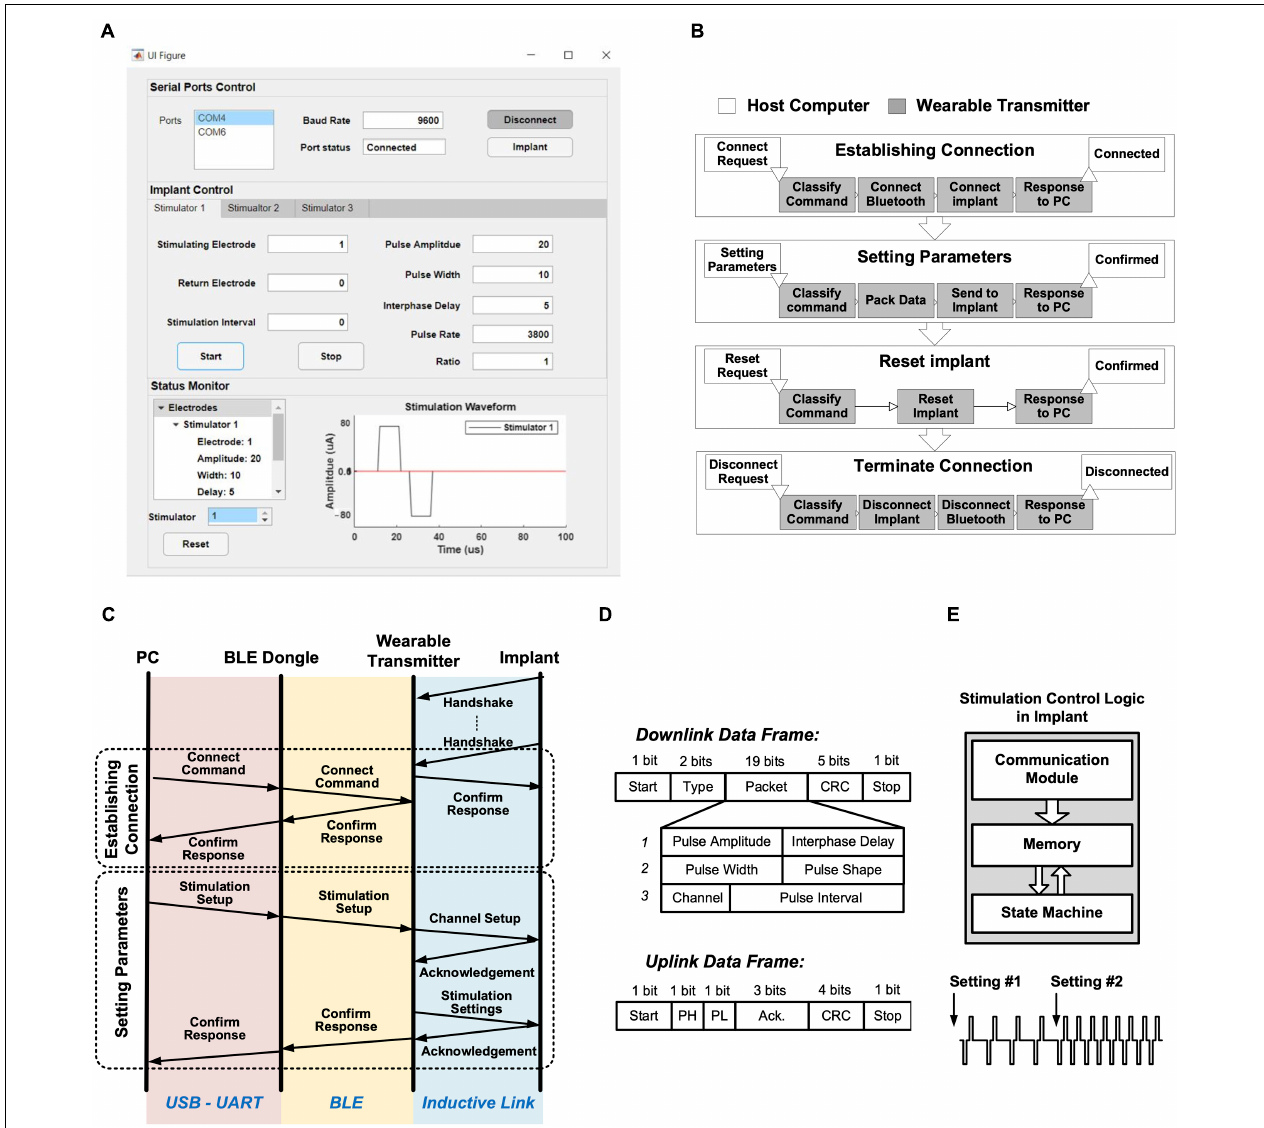
FIGURE 5 | Stimulation control protocol: (A) Graphical user interface; (B) Four procedures for operating the implant from a host computer, with flowcharts on the wearable transmitter in each procedure; (C) Overall communication procedure between the host computer and the implant for establishing connection and setting stimulation parameters; (D) Structure of the data frames over the inductive link; (E) Block diagram of the stimulation control logic in the implant, with an example of changing stimulation parameters